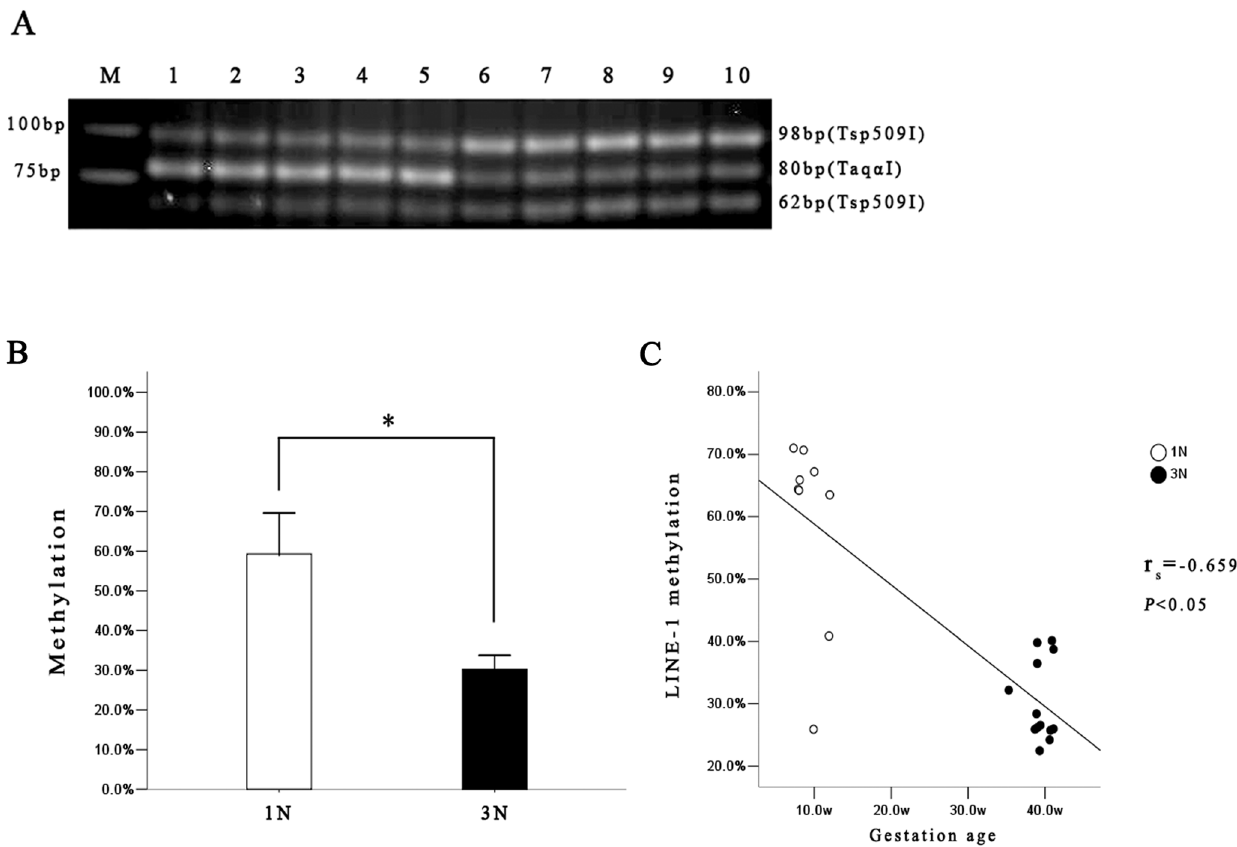
Figure 2. Assessment of LINE-1 methylation of first (1N) and third trimester (3N) placentas by COBRA. A . A representative gel picture of LINE-1 COBRA showing the DNA bands for methylated (80 bp) and unmethylated LINE-1(98 bp and 62 bp). Lanes 1–5: 1N placental samples; Lane 6– 10: 3N placental samples. B . The results of densitometry analyses on LINE-1 methylation. LINE-1 is hypomethylated in 3N placentas (Mean: 30.2%) relative to 1N placentas (Mean: 59.3%). * P , 0.05. C . Inverse correlation between LINE-1 methylation levels with gestation age. W: weeks.